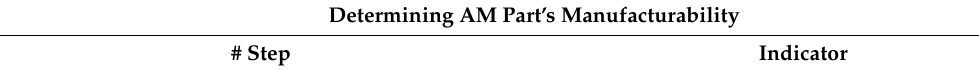
Table 3. Framework of the AM manufacturability determination.